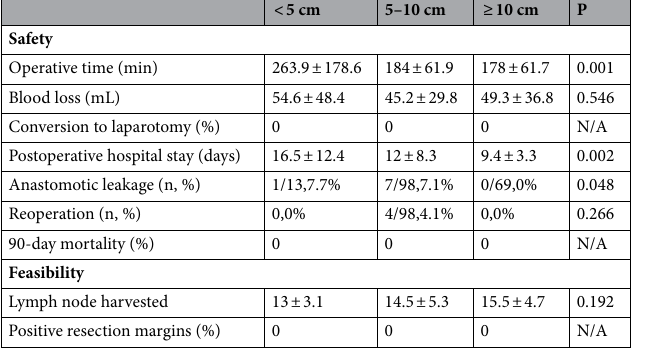
Table 4. Influence on robotic NOSES by the distance between the lower edge of the tumor to the dentate line.